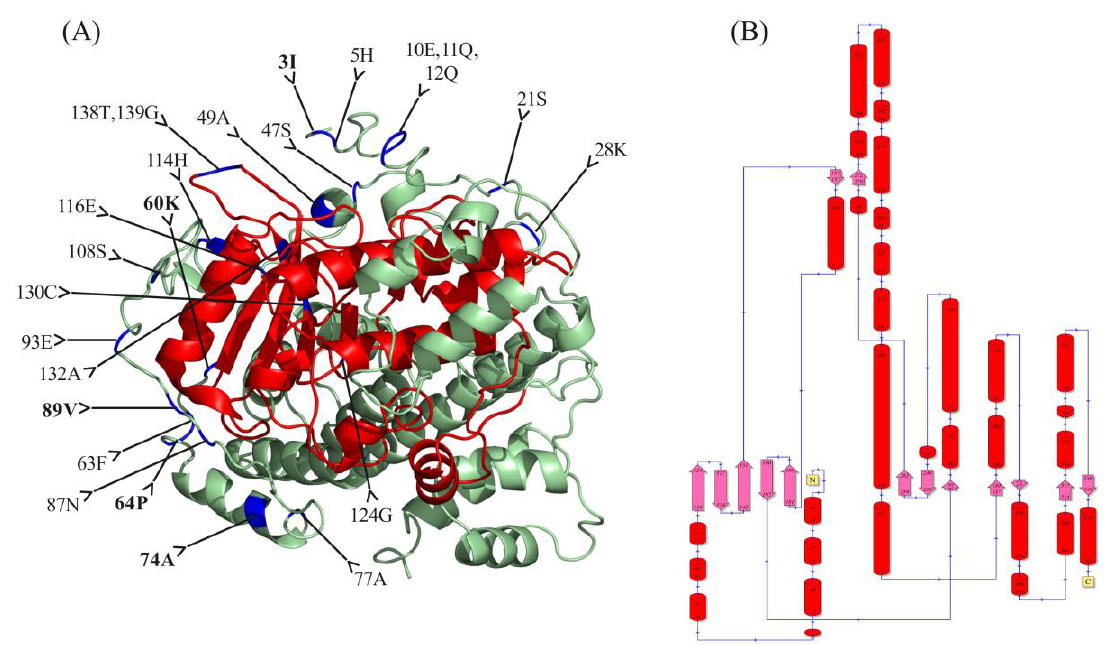
Figure 3. Three-dimensional putative architecture of BnaC01CRK1. ( A ) The N-terminal PKINASE domain is highlighted in red and blue shows the specific amino acid sites that are perceived to be involved in the functional divergence of the BnaCRKs . Amino acid sites that are predicted in both type I and type II functional divergence are indicated in bold letters. ( B ) The putative 2D structure of BnaC01CRK1. The pink arrows represent the strands, and the round cylinders indicate the helix.